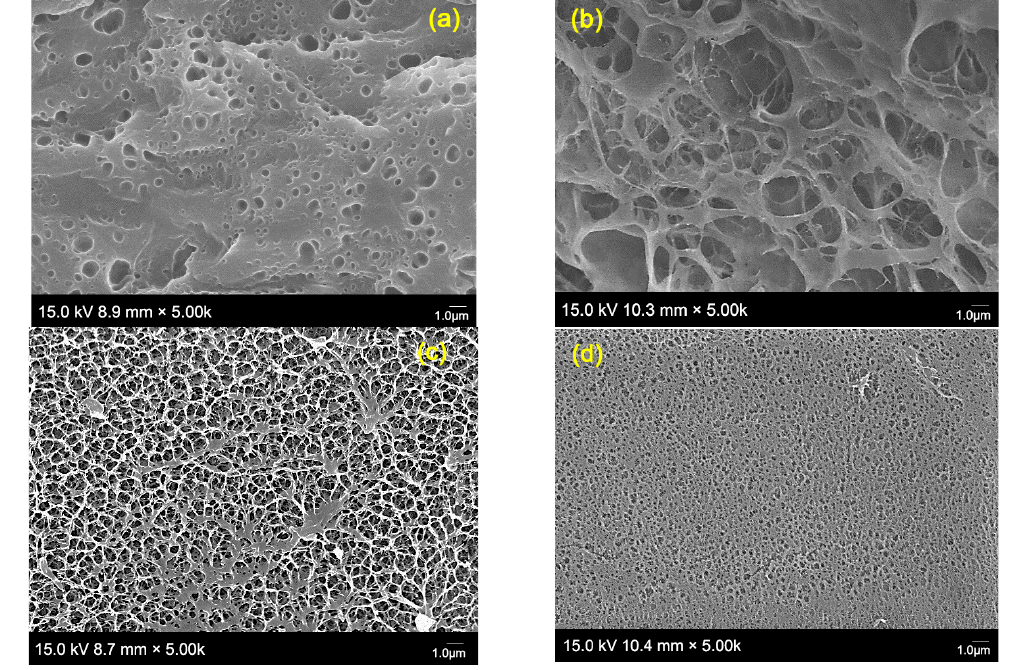
Figure 4. Cross-sectional SEM morphologies of ( a ) PVAEM, ( b ) PVAFT, ( c ) PVAHM/25 °C, and ( d ) PVAHM/70 °C. Table 2. Statistics data on the pore size and pore size distribution based on SEM